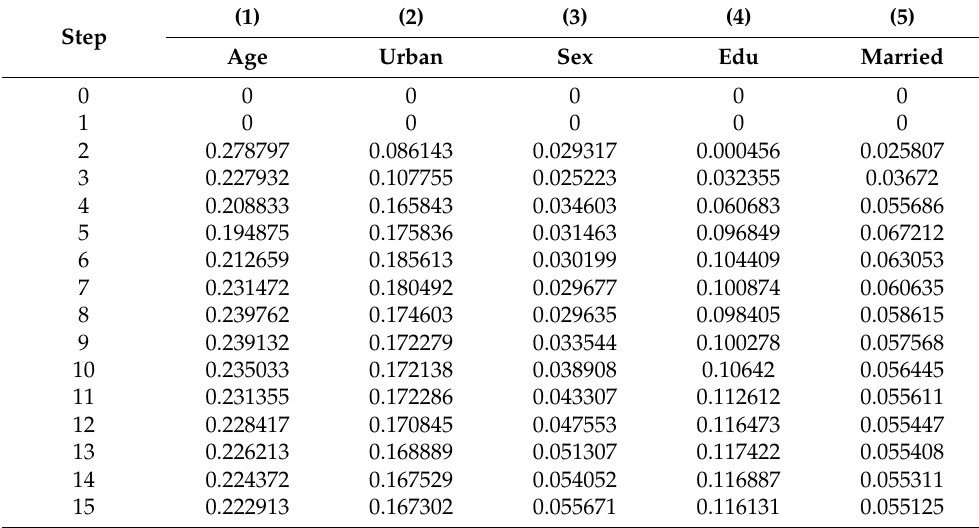
Table 5. Variance decomposition results of variable lnhealthins impacted by various factor variables.